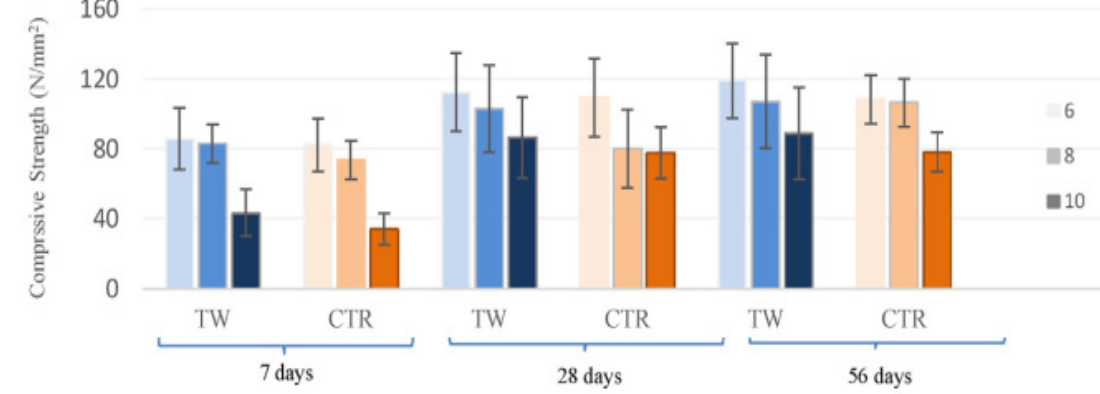
Figure 3. CS of composites at different ages with various recycled waste fiber additions [53]. Textile waste (TW); control kraft pulp (CTR) .